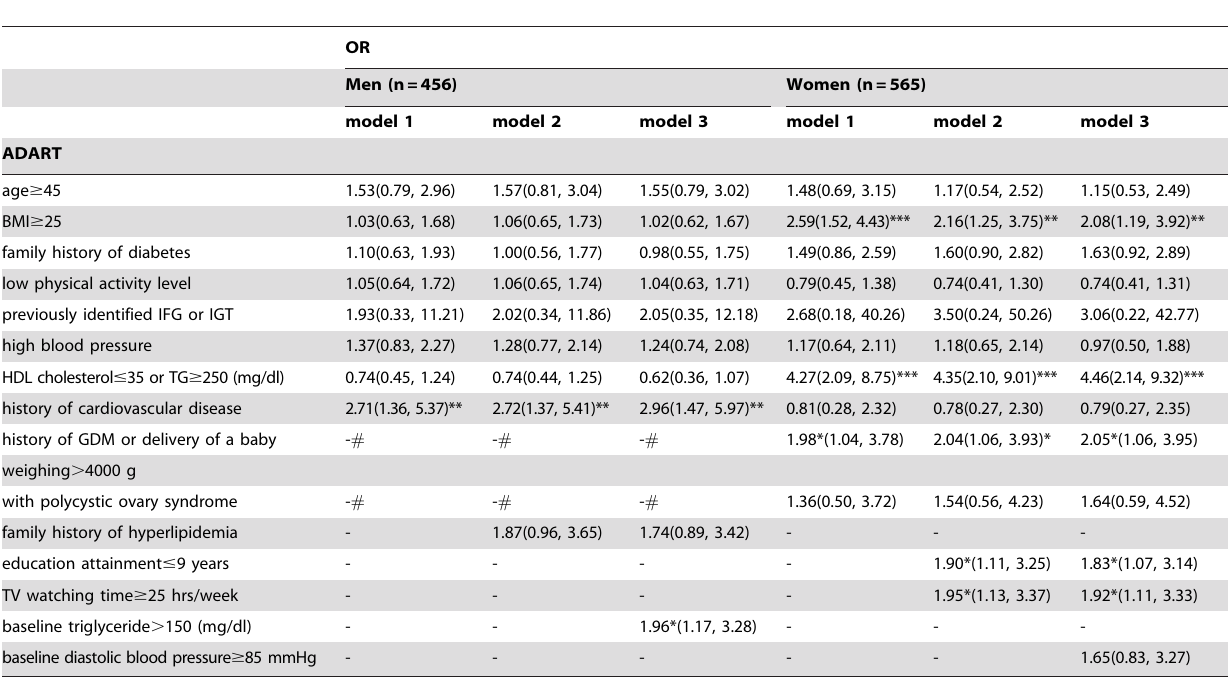
Table 2. The ability of ADART plus lifestyle behaviors and biomarkers at baseline for predicting 3-year incidence of pre-diabetes and